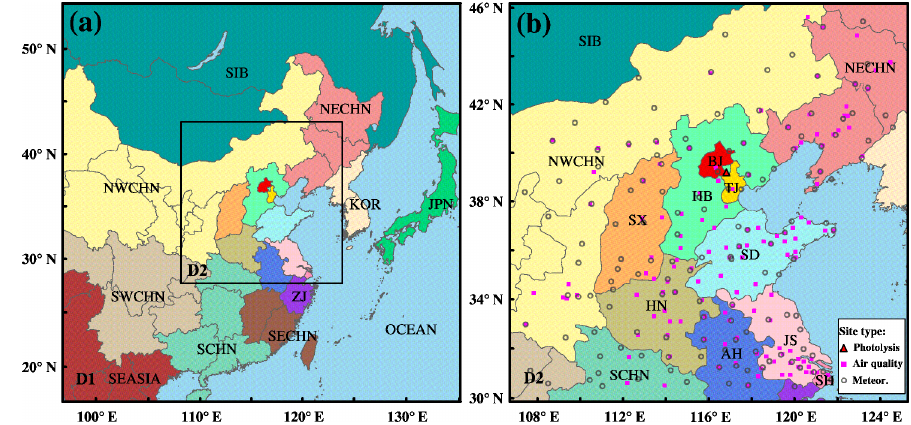
Figure 1. Model domain. Hundreds of observations are used for model validation; locations and types of observation stations are shown in (b) . The figure also shows the source regions denoted by different colors. Abbreviations are defined in Table S1 of the Supplement. Table 1. Major configuration options of WRF-Chem used for this study. Item Selection Reference Photolysis